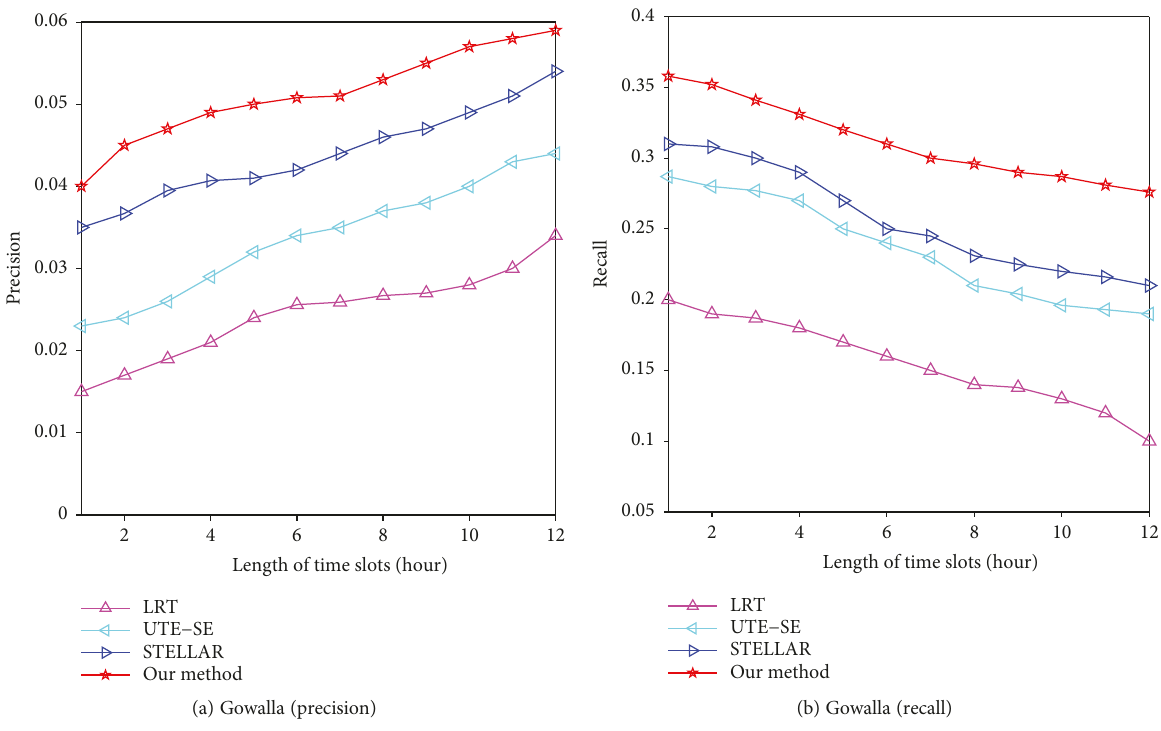
Figure 10: Performance of the varying length of time slot on the Gowalla dataset.